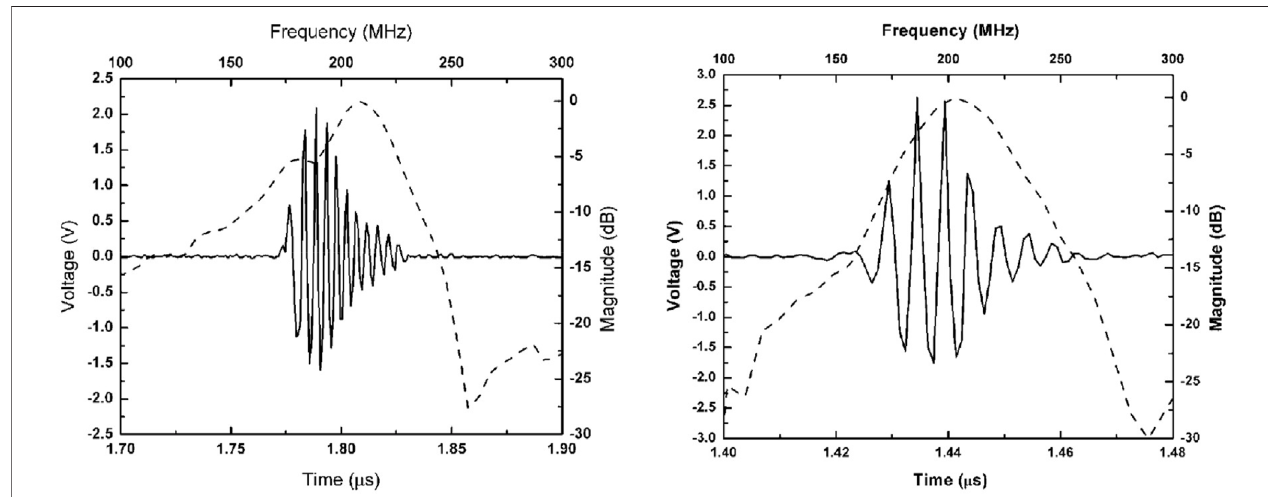
FIGURE 9 | Time-domain pulse/echo response (solid line) and frequency spectrum (dashed line) of the 200 MHz LiNbO3PF transducer (left) ; Time-domain pulse/ echo response (solid line) and frequency spectrum (dashed line) of the 200 MHz ZnO SF transducer (right) .